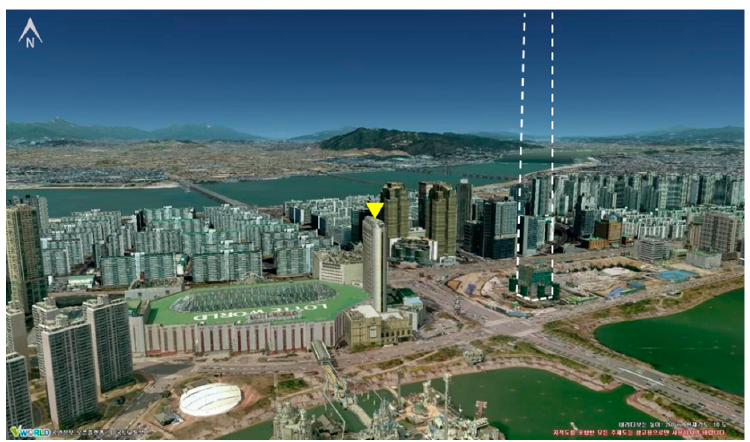
Figure 6. Virtual landscape around the Lotte World Tower in Seoul (white dashed line indicates the Lotte World Tower under construction, and yellow triangle indicates the RS campaign site).